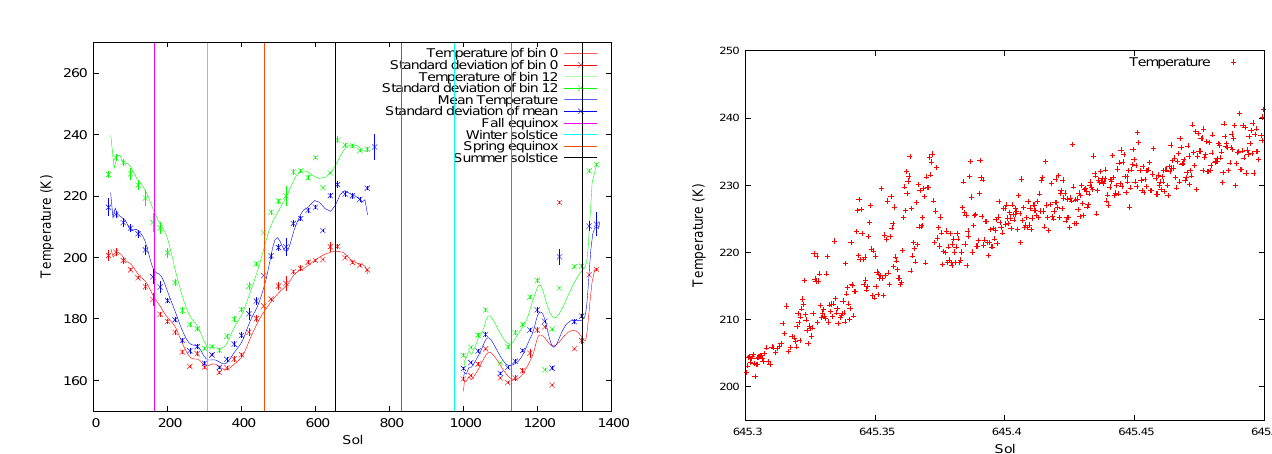
Fig. 4. ULT and OPS temperature data of all the VL2 sols, bin 12.